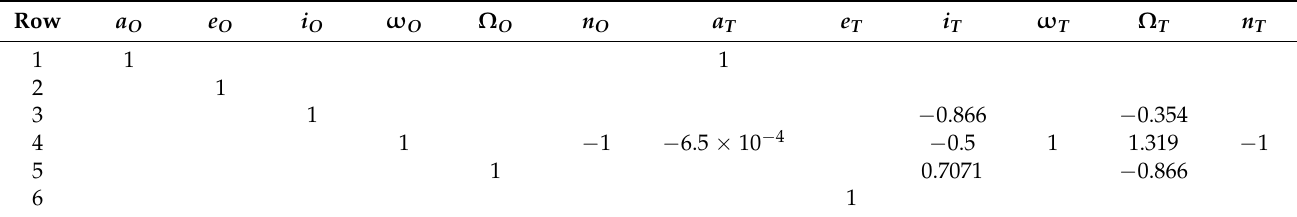
Table 6. The reduced row echelon in same circular orbit case.